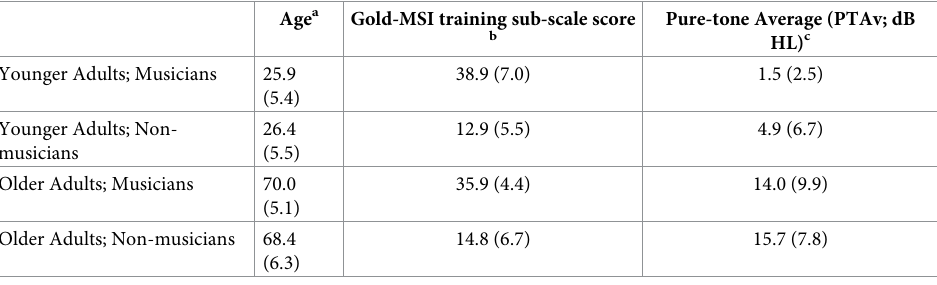
Table 1. Participant demographics–Experiment